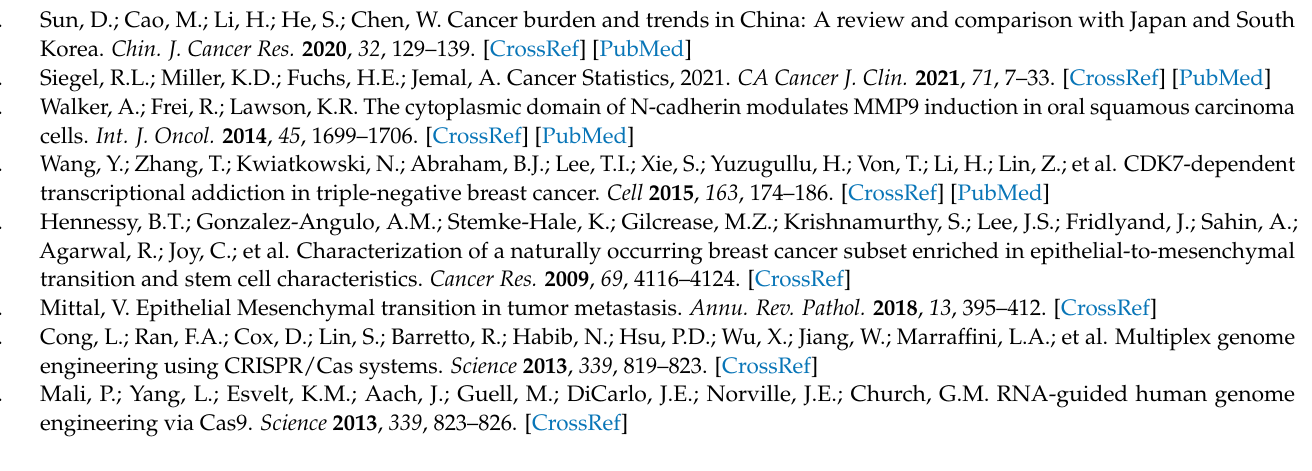
Figure S2. Transfection efficiency and cytotoxicity of GVs–PEI–DNA(GPD) vs lipofectamine 2000. (A) Quantitative fluorescence analysis of Cas9- and EGFP-stably expressed 4T1 cells transfected with only pU6-sgRNA (Cdh2)-mCherry(control), GPD, GPD + US, or lipofectamine 2000. ( n = 3). (B) Cell viability of Cas9- and EGFP-stably expressed 4T1s determined through the CCK-8 assay. ( n = 3). ns denotes p > 0.05, *** p < 0.001. Figure S3. Sanger sequencing results of wild-type (WT) and Cdh2-edited cell lines. (A) Sanger sequencing results of 13 cell lines with gene mutations in target regions. gRNA1 and gRNA2 were designed as two target sites. (B) Sequencing peaks for WT and one of the Cdh2-edited cell lines,